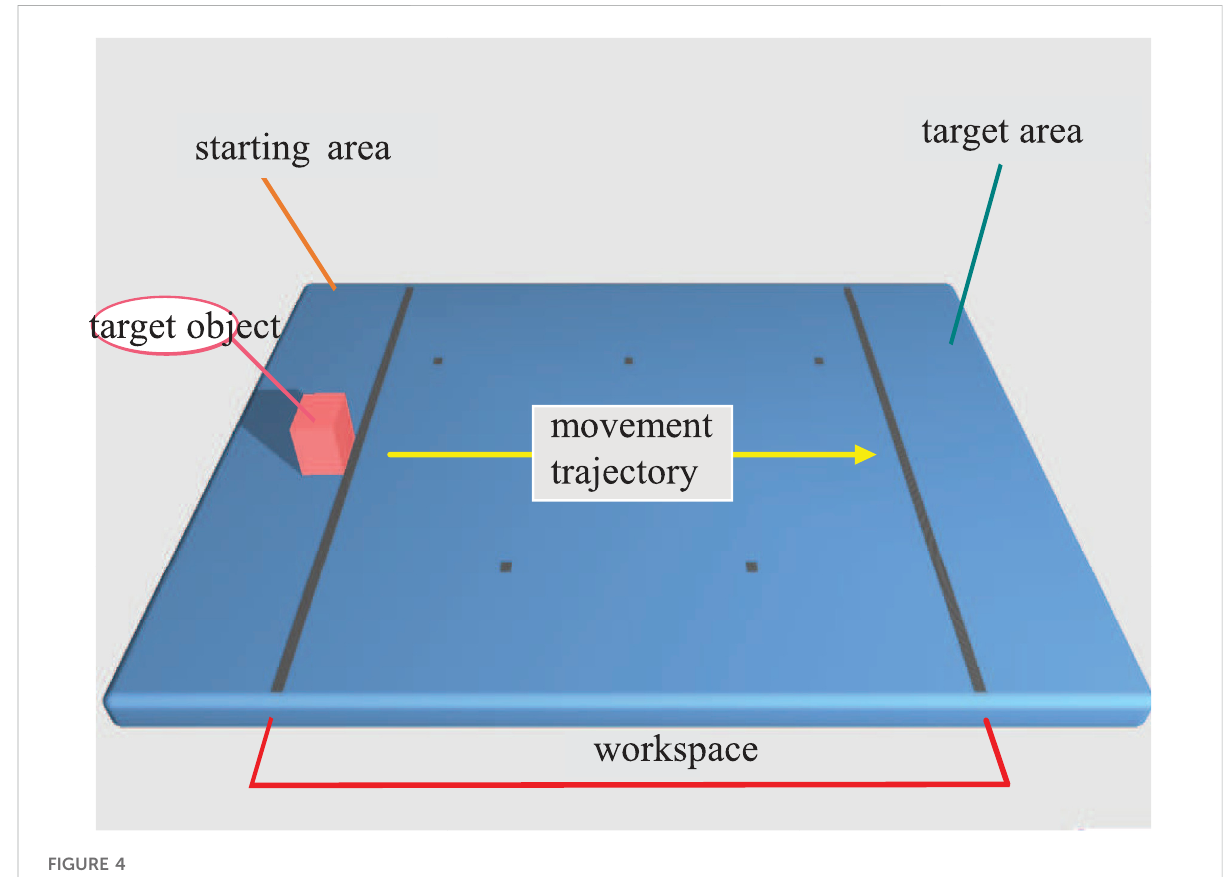
Designed interactive task: fi